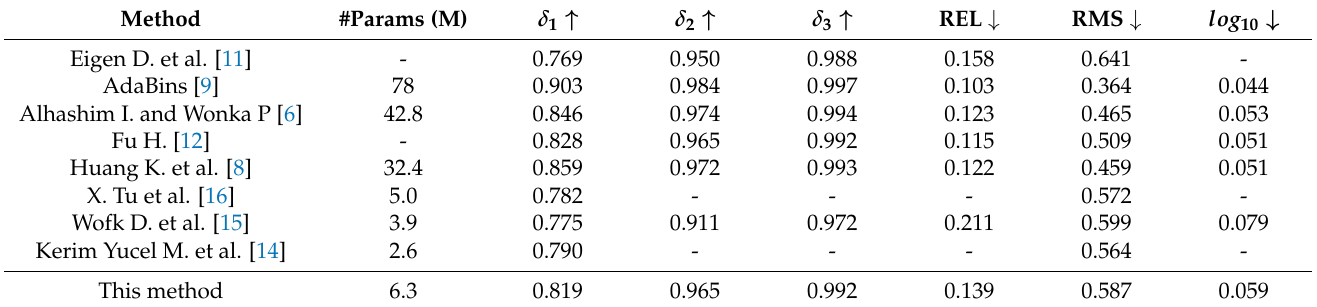
Figure 4. Loss curves for network introduced in Section 2.1. Training has been done using dataset from Section 2.4. Table 1. Comparison of performance of various depth estimation neural networks on the NYU- Depth-v2 dataset. The results are reported from the original papers. Last row is the results of the proposed network. The second column shows numbers of parameters in millions